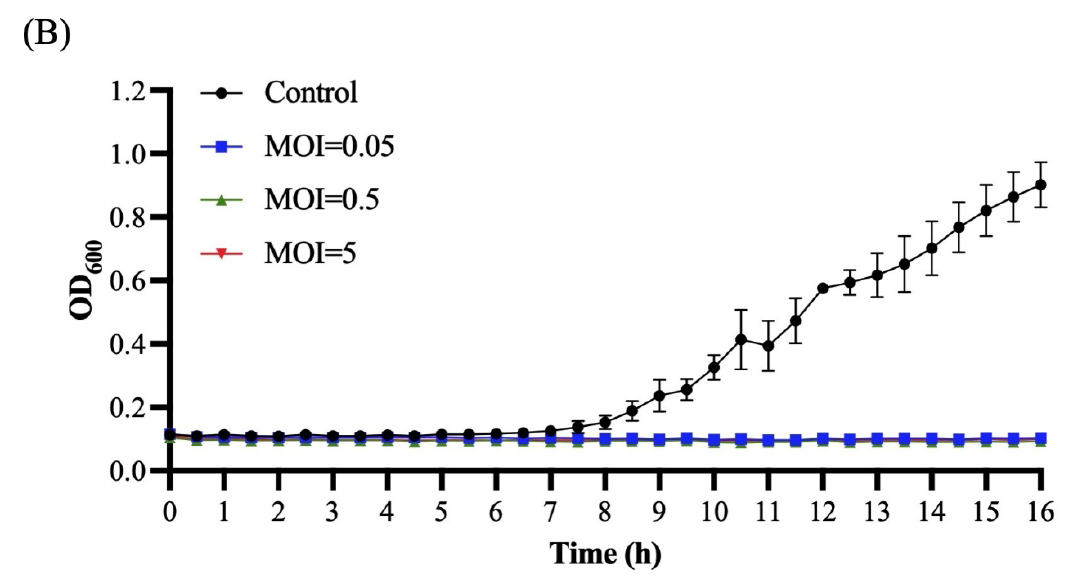
Figure 7. Bacterial challenge assay for E. coli O45:H16 ( A ) and E. coli O45:H2 ( B ) treated with phage Ro45lw at MOIs of 0.1, 1 and 10 at 25 °C for 17.5 h based on the bacterial optical density at wave- length 600 nm (OD 600 ). The Control group only contains bacterial culture.